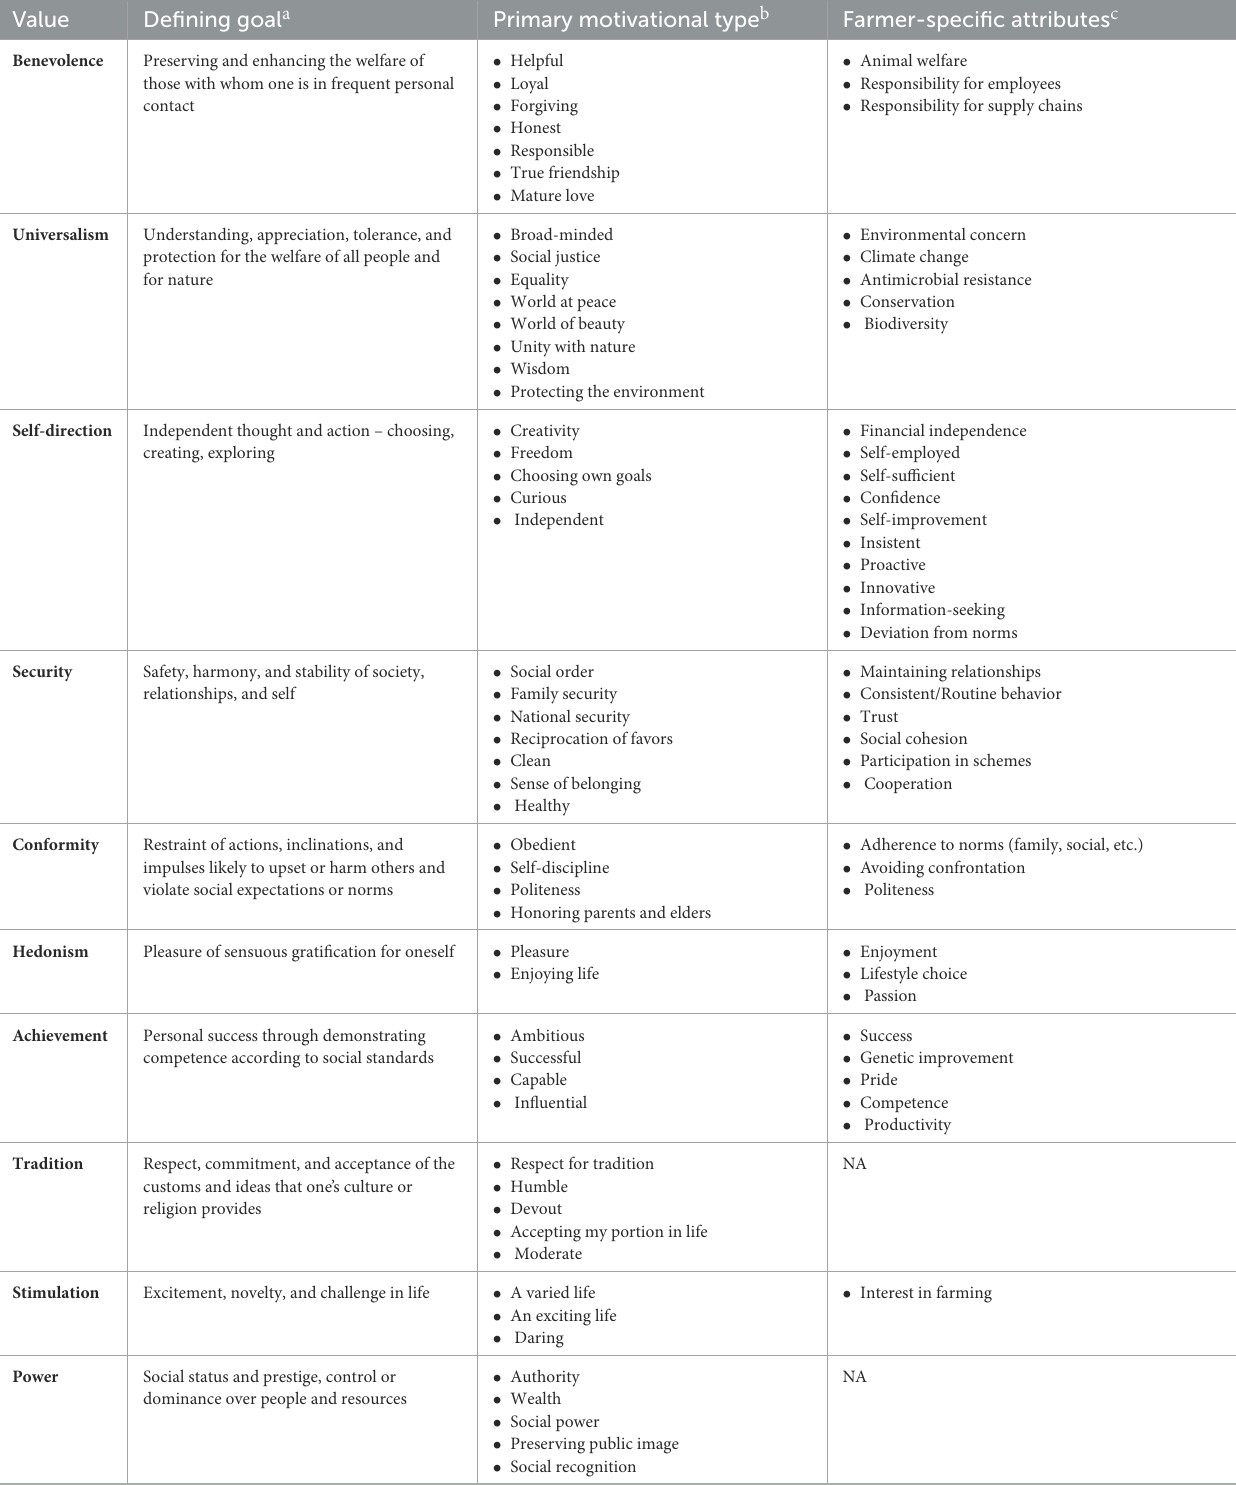
TABLE 1 Description of the ten basic values (in order of cultural importance) as well as author interpretation of values in relation to farming behaviors. Value Defining goal